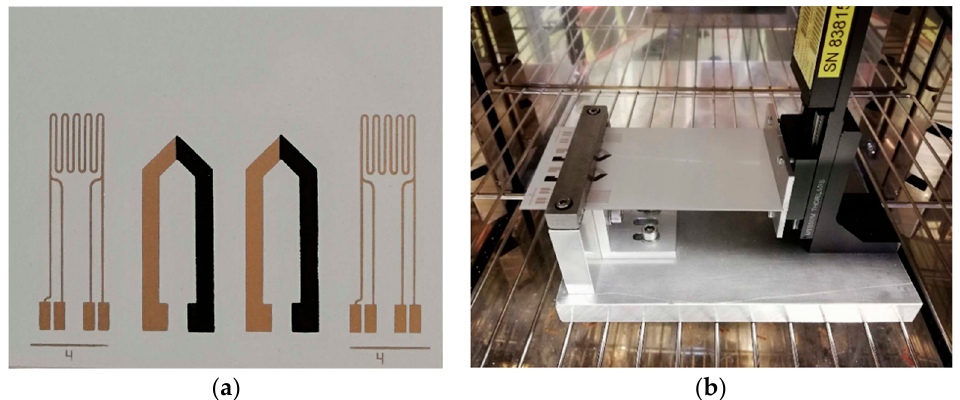
Figure 2. ( a ) Screen printed silver strain gauge with four wire connections and silver carbon black thermocouple printed on insulated sheet steel for bending characterization; ( b ) Bending test setup consisting of motorized stage and clamping.